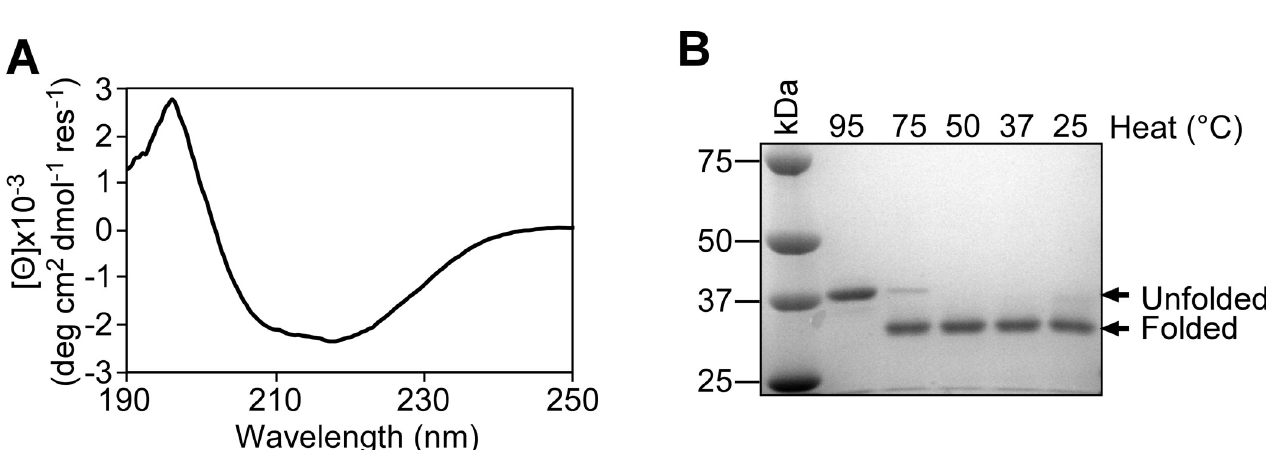
Fig 5. Secondary structural analyses of purified FopA. (A) Circular dichroism spectroscopy of membrane translocated FopA. The far-UV spectrum shows characteristic minimum and maximum ellipticities near 218 and 196 nm, respectively the characteristic values for β -strand-rich proteins. (B) Heat modifiability of FopA tested by SDS-PAGE stained with Coomassie blue. Unfolded FopA runs at the expected theoretical MW of mature FopA-His8 (40.2 kDa), while the folded FopA runs at an apparent MW of ~35 kDa.